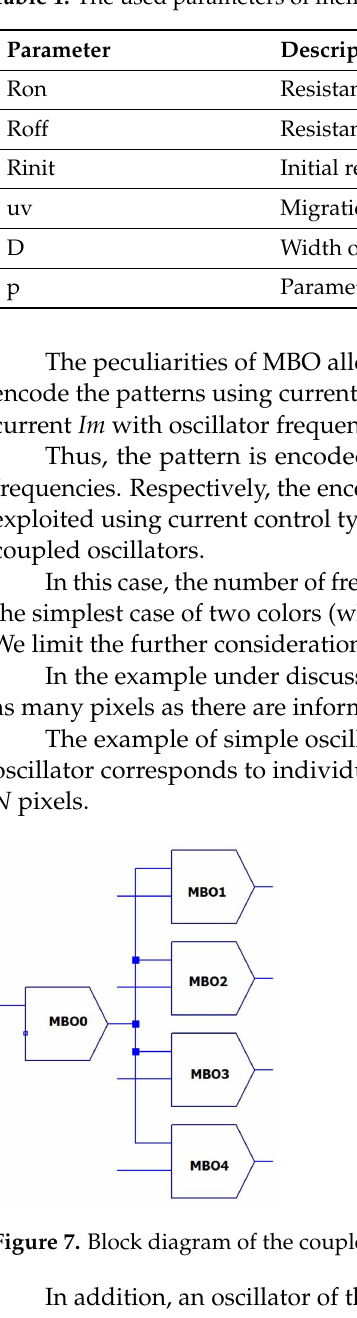
Table 1. The used parameters of memristor model.